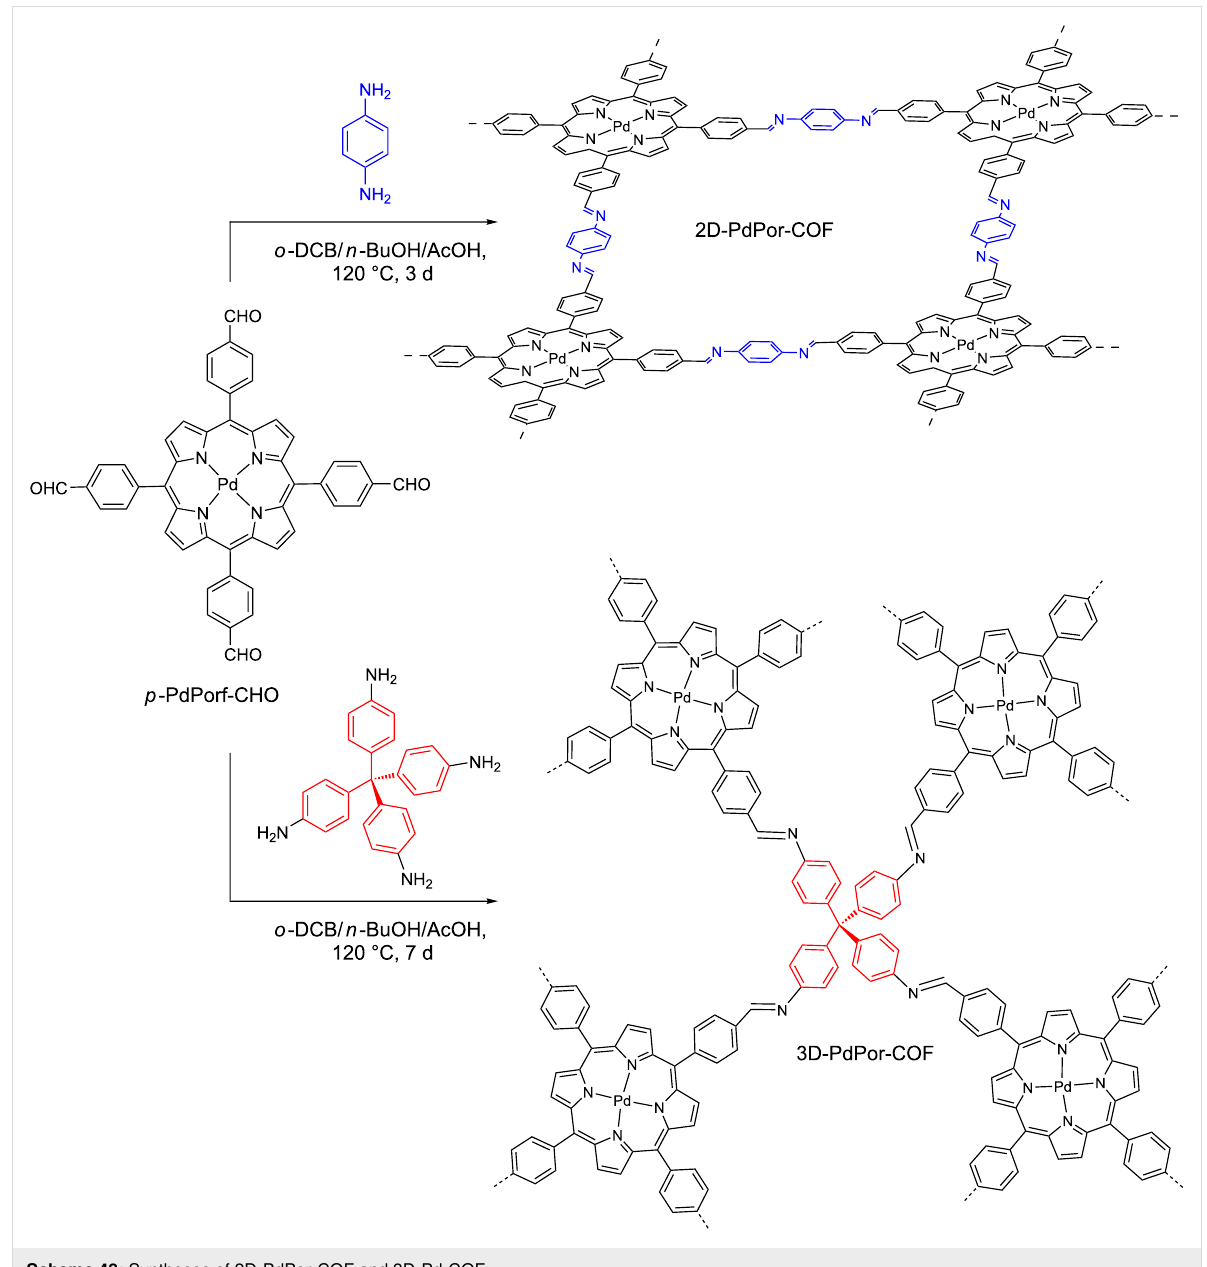
Scheme 48: Syntheses of 2D-PdPor-COF and 3D-Pd-COF.